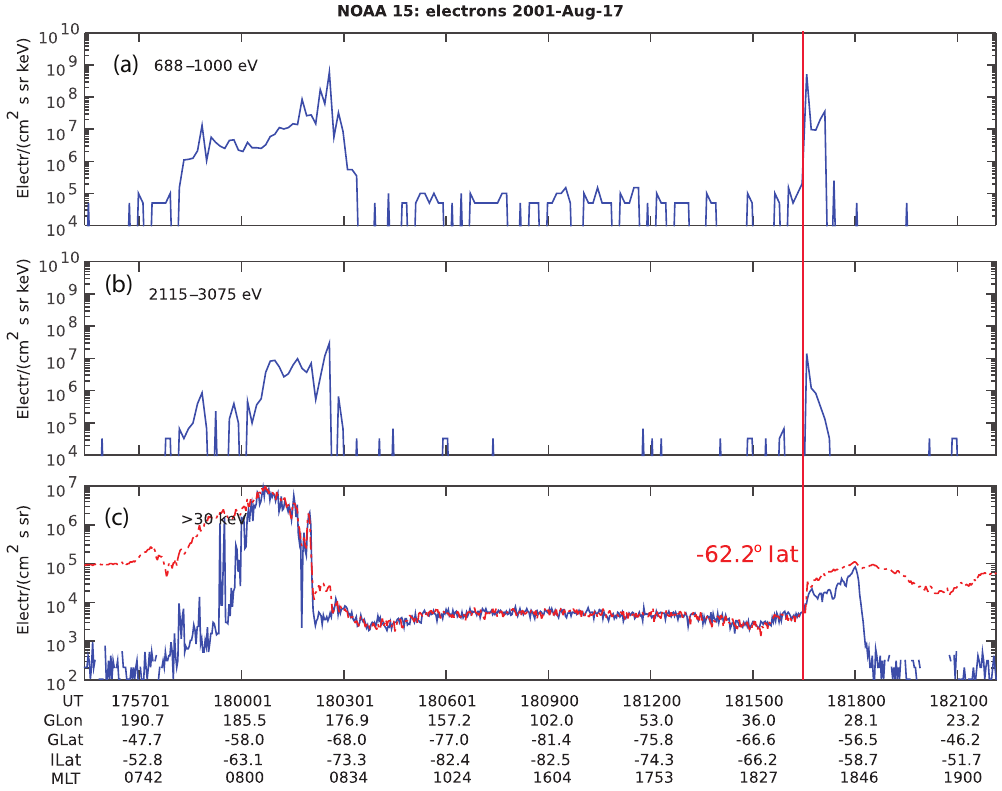
Figure 6. Particle measurements from NOAA 15 pass in the Southern Hemisphere on 17 August 2001; see trajectory in Fig. 4c. It passed through the dusk-side aurora at 18:17UT. (a) Electron flux: 688–1000eV. (b) Electron flux: 2115–3075eV. (c) Electron flux: ≥ 30keV, where the blue line shows electrons within the loss cone and the red line shows the locally mirroring electrons. The red vertical line shows the poleward edge of precipitation at − 62 . 2 ◦ magnetic